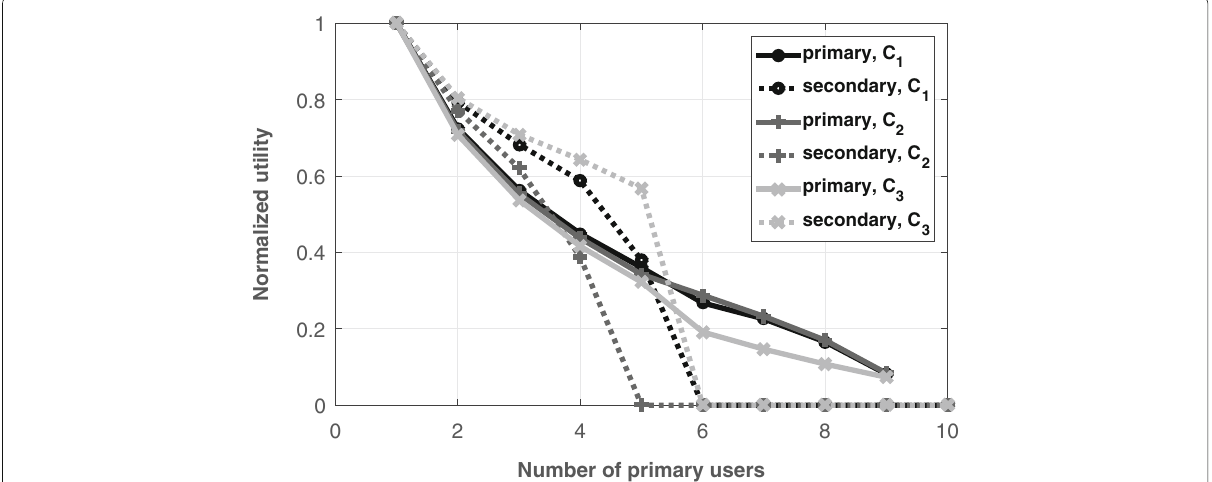
Fig. 7 The two players’ normalized utilities versus the number of primary users with n s = 3, λ p = 10 kbps, λ s = 1 kbps, and μ = 100 kbps and three cost functions with C 1 , C 2 , and C 3 defined by Eqs. 11, 22, and 23,